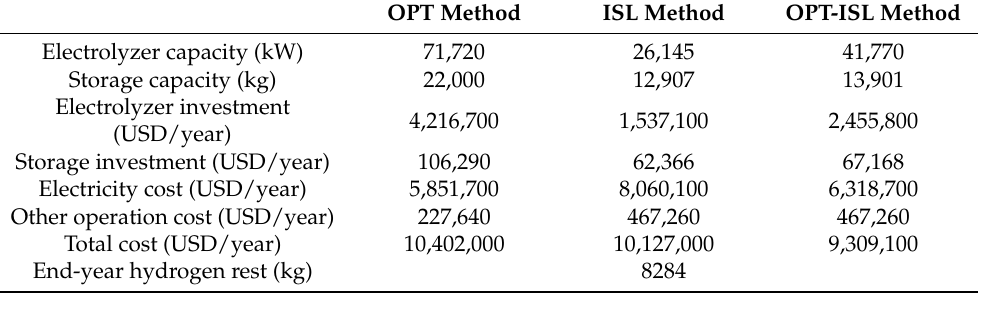
Table 4. Optimization results and capacity configuration.